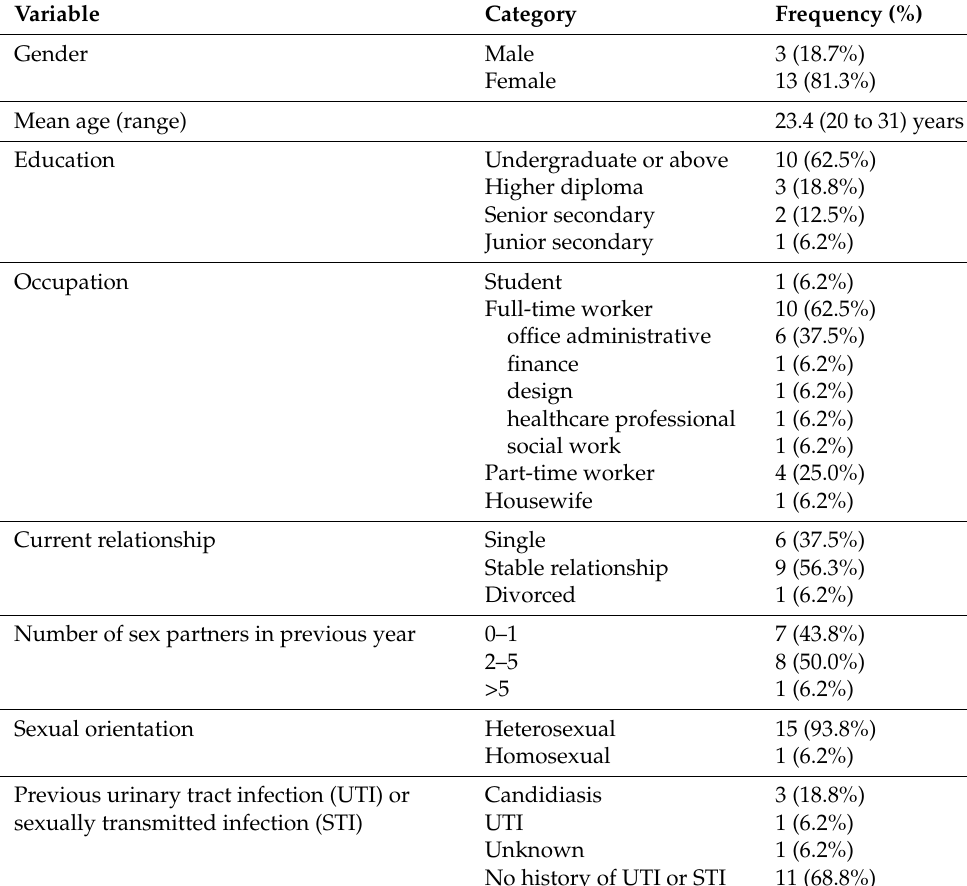
Table 1. Sample characteristics (N =